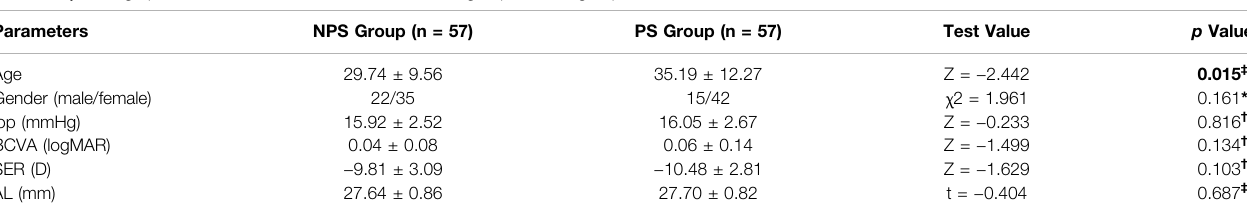
TABLE 1 | Demographics and baseline characteristics of NPS group and PS